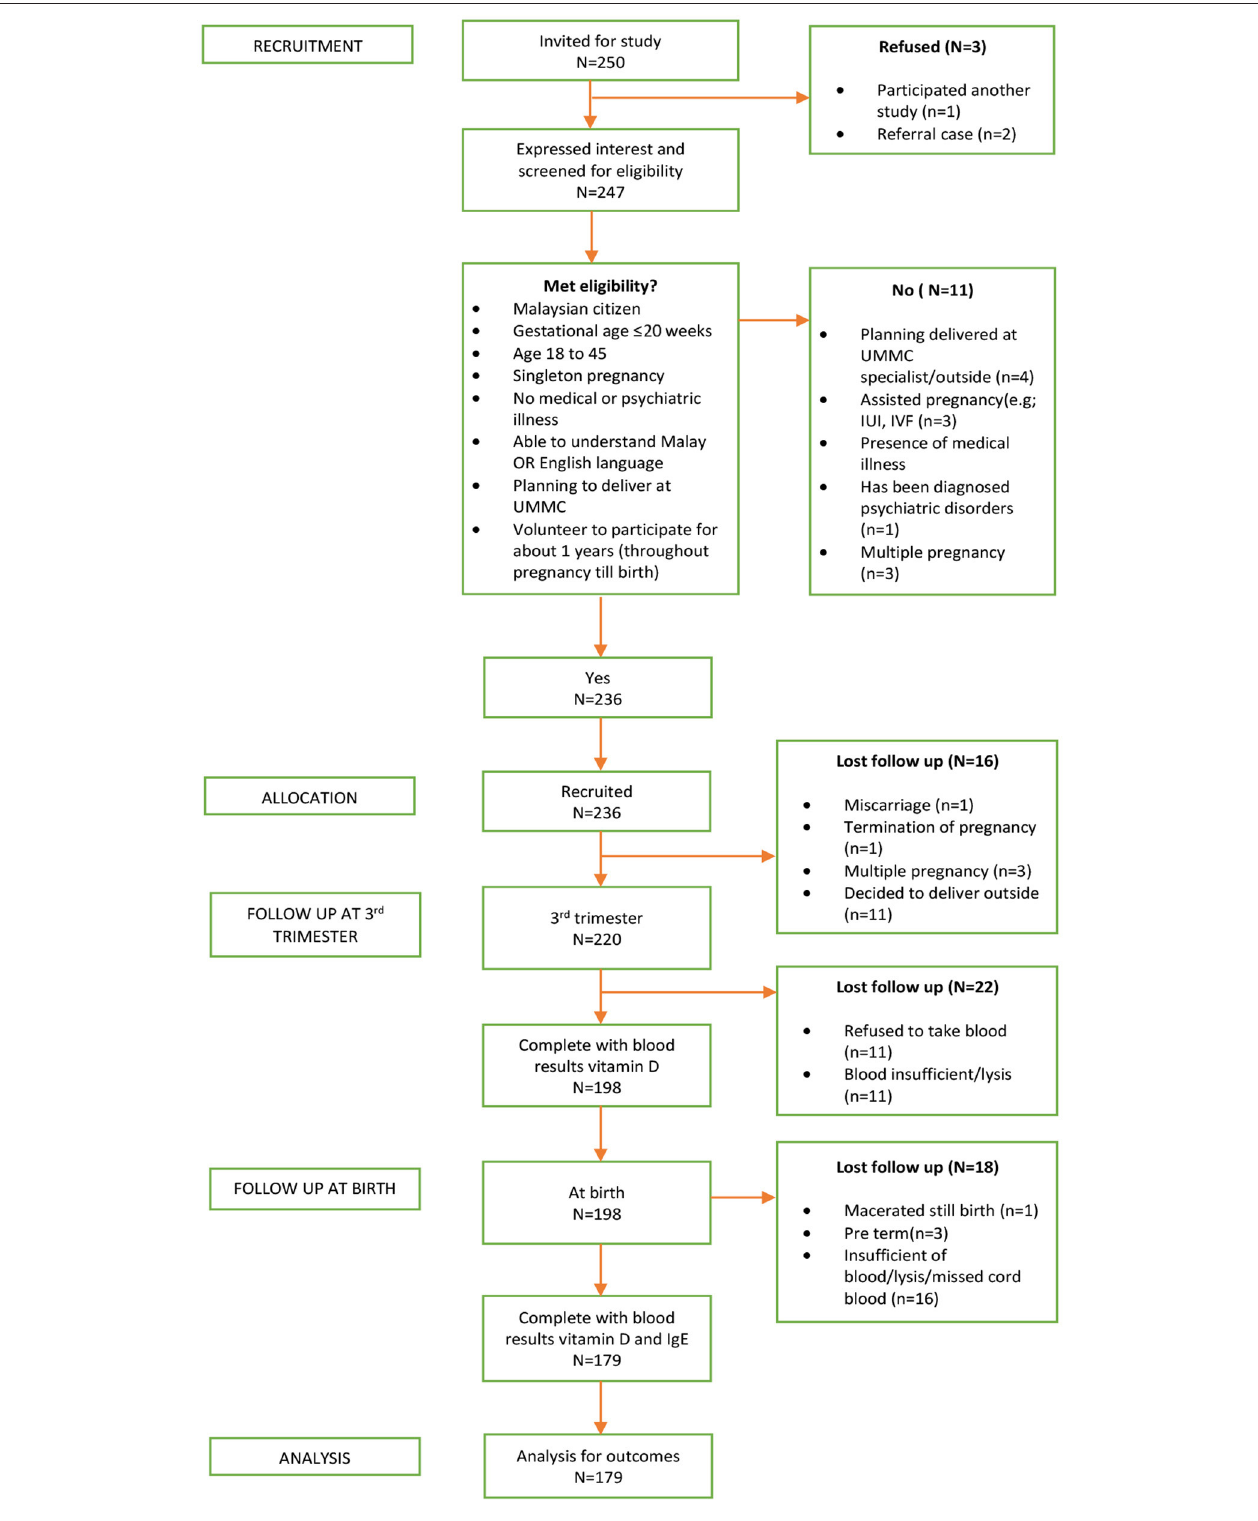
FIGURE 1 | Recruitment flow diagram of the prospective cohort study.